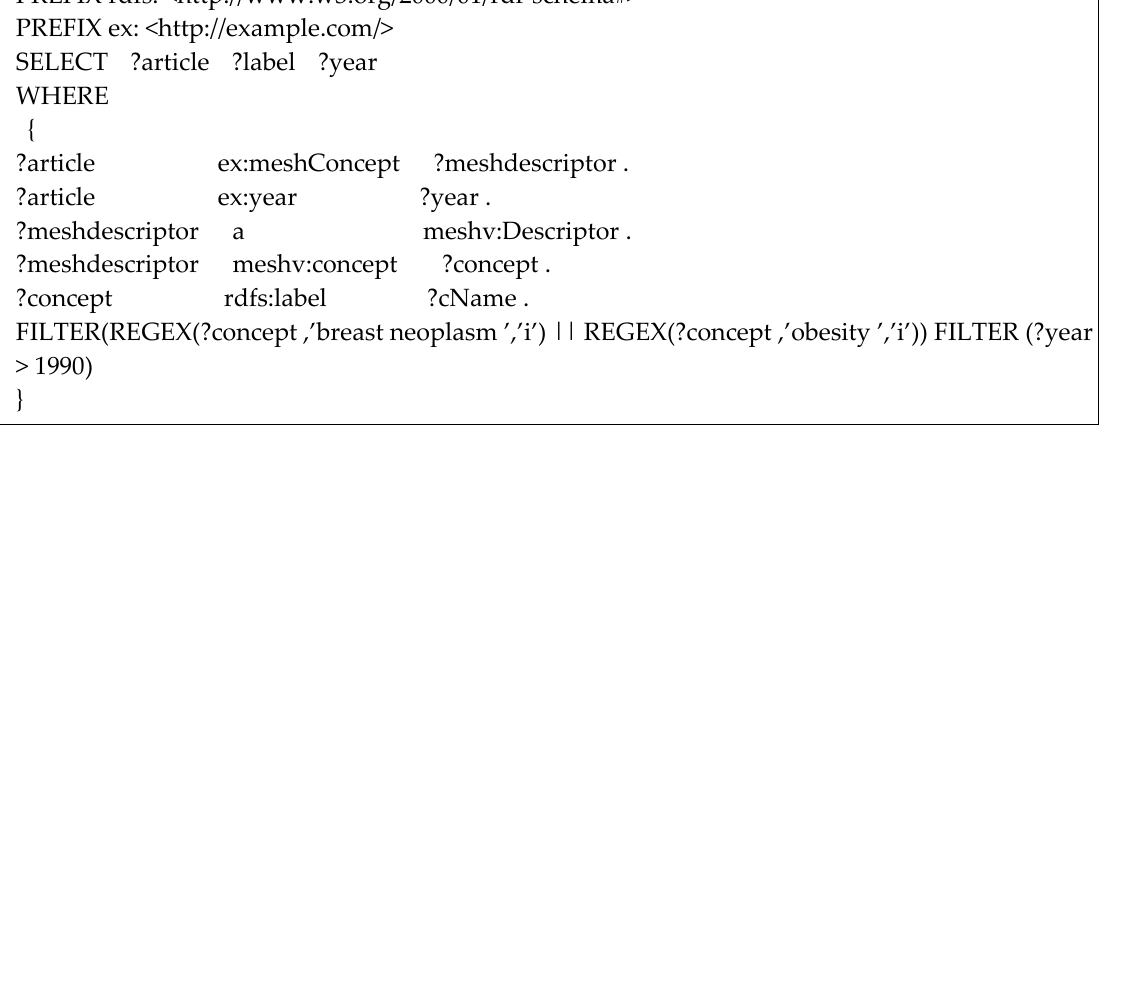
Figure 2. Schematic steps of the systematic review process along with the advantages of using Semantic Web/Linked Data technologies. 4.2. Meta ‐ Analysis After the systematic review process and identifying candidate mechanistic links in the previous step, the next step is to identify the key publications with their data available in publicly accessible databases. The time ‐ consuming step here is to go through all the publications screened at the systematic review phase to identify the type of data available from each publication, assess its relevance, extract the links to the data, and download the data from the